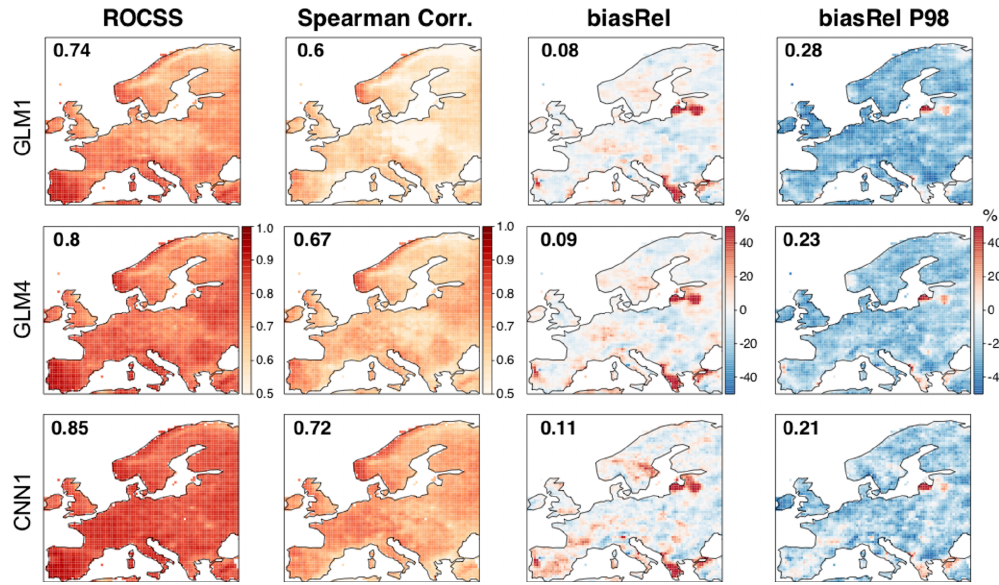
Figure 8. As in Fig. 5 but for precipitation. In this case, CNN1 is taken as the best-performing method (bottom row). The numbers within the panels show the spatial mean absolute values (to avoid error